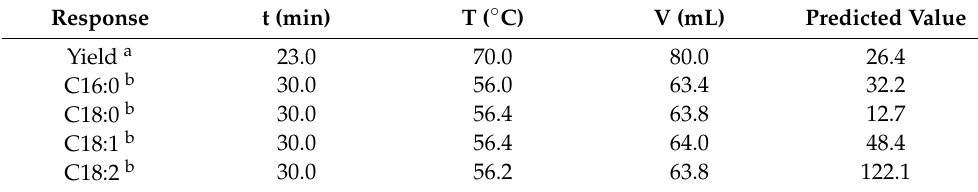
Table 3. Single response optimized MAE conditions and predicted values to maximize TSO extraction yield and FAMEs